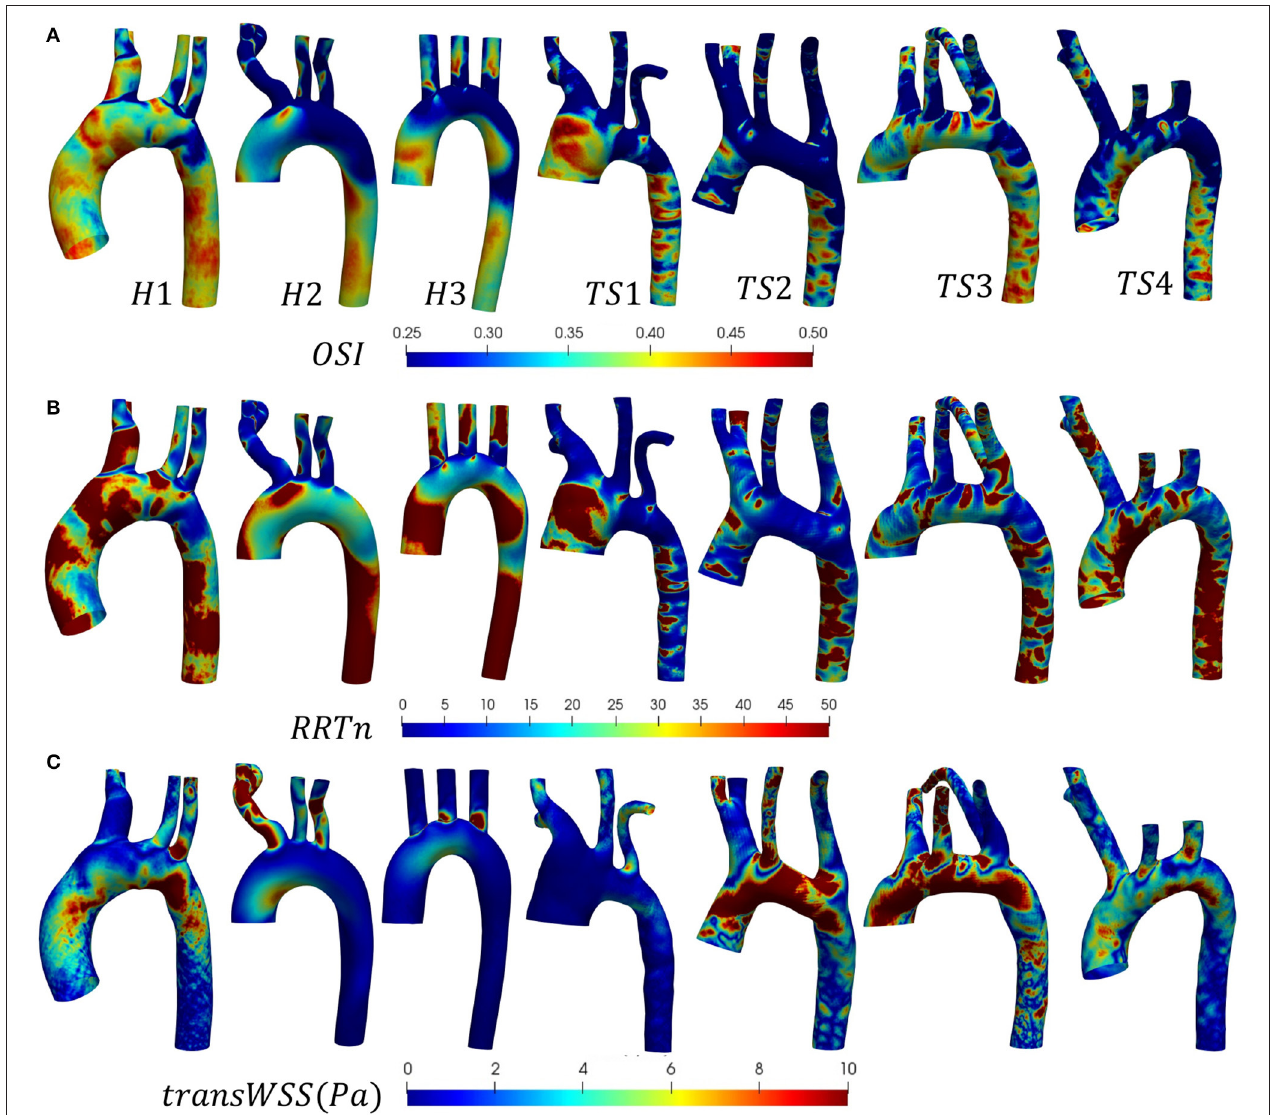
FIGURE 7 | (A) Oscillatory shear index (OSI), (B) normalized relative residence time (RRTn), based on the surface integral average for each individual case, and (C) transverse wall shear stress (transWSS) distributions shown (anterior view) for the (H1-H3) healthy and (TS1-T4) Turner syndrome cases.